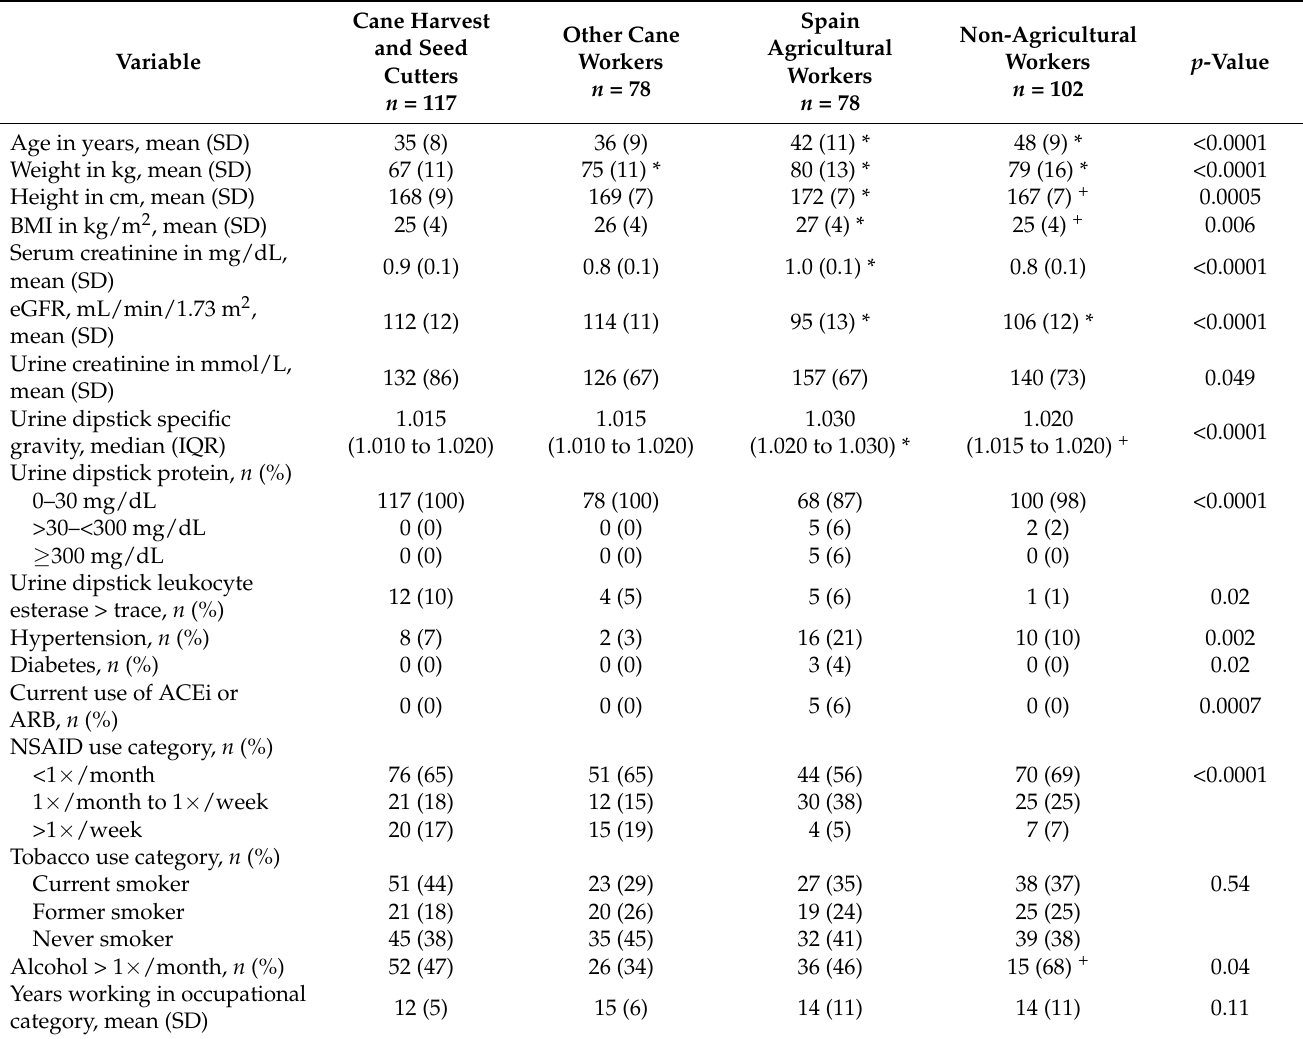
Table 2. Baseline and basic laboratory features of the study populations. * indicates a difference in pairwise comparison from the cane harvest and seed cutters group. + indicates that data were derived only from the brickmaker subgroup as they were not available from the miner